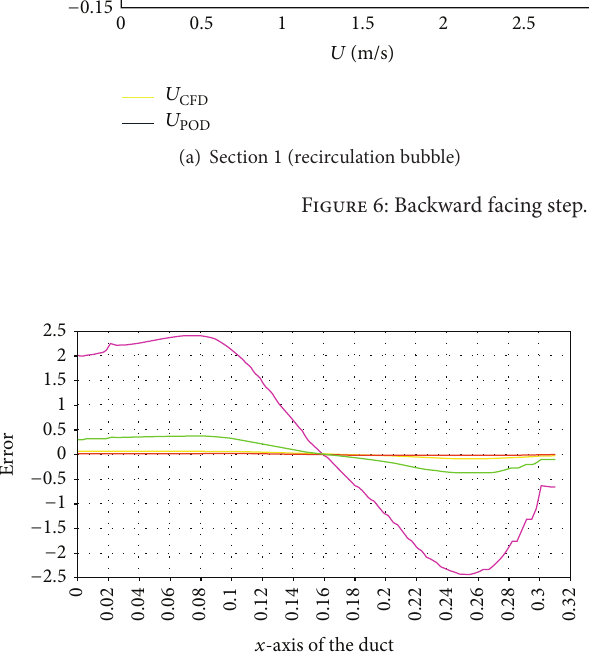
Figure 8: Backward facing step. Error ‖𝑒‖ ∞ on the pressure field with respect to the number of snapshots.